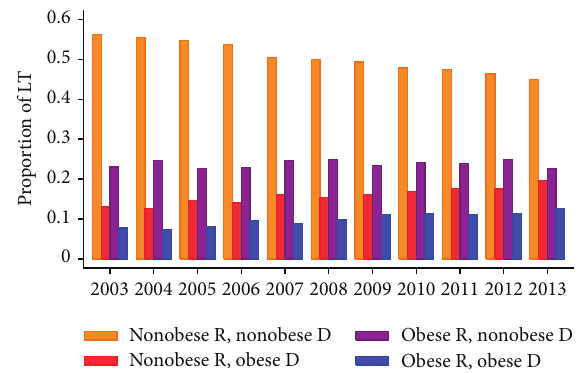
Figure 1: Proportions of liver transplants involving obese recipients and obese donors, by year of transplant ( 𝑁 = 51 ,556).